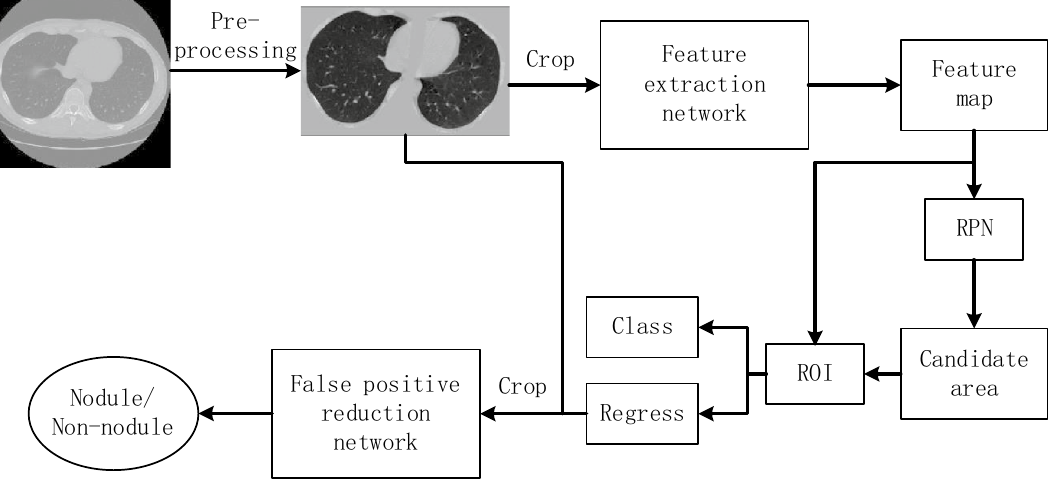
Figure 1. Automatic pulmonary nodule detection system based on MSA convolutional neural network.